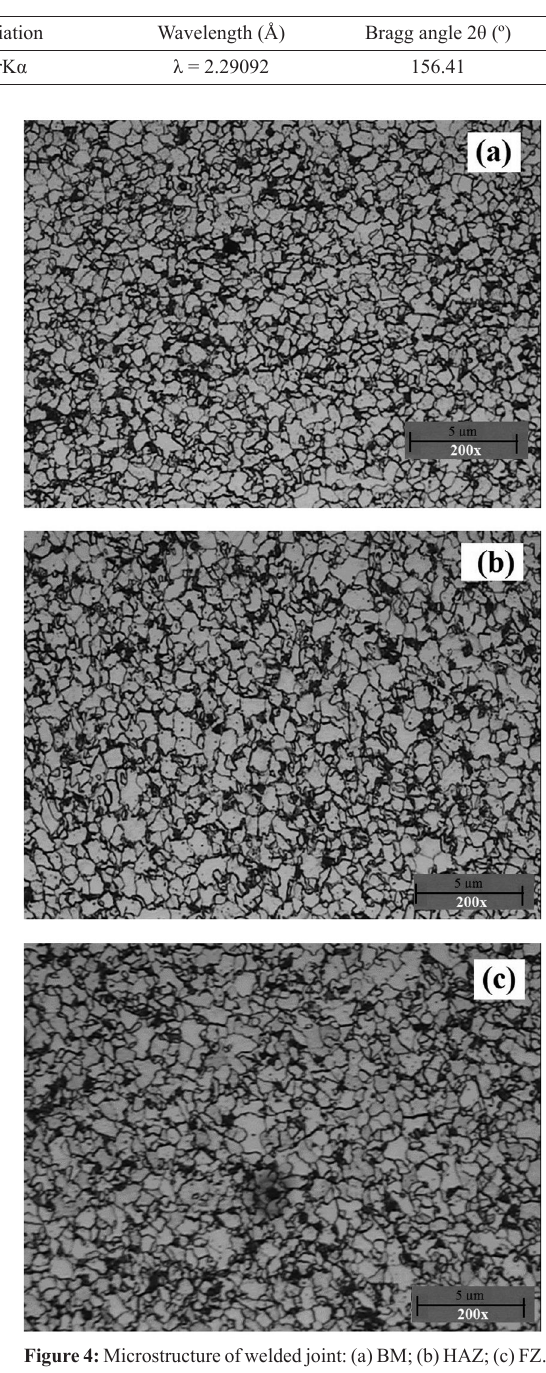
Figure 4: Microstructure of welded joint: (a) BM; (b) HAZ; (c)